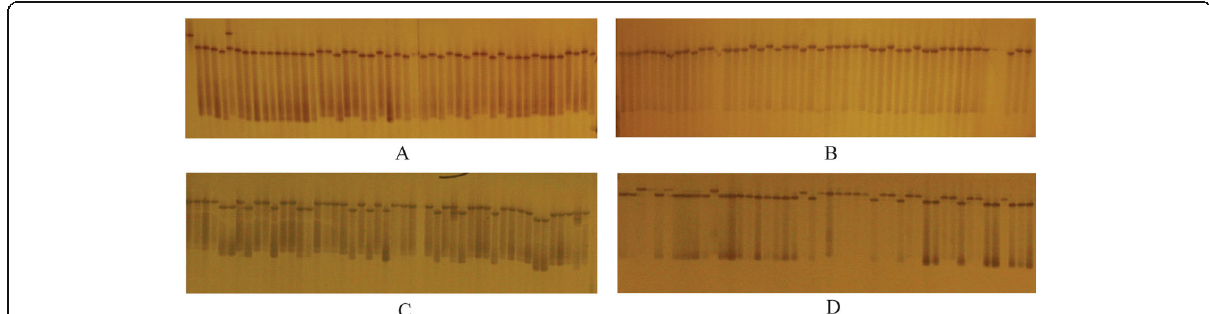
Fig. 1 DNA fragments amplified by selected SSR primers. Electrophoresis results obtained for 48 germplasm lines from three cotton-growing regions. Denatured PCR products were separated on a 6% polyacrylamide gel and then stained with silver nitrate. a primer PC44; b primer PC37; c primer PC25; d primer